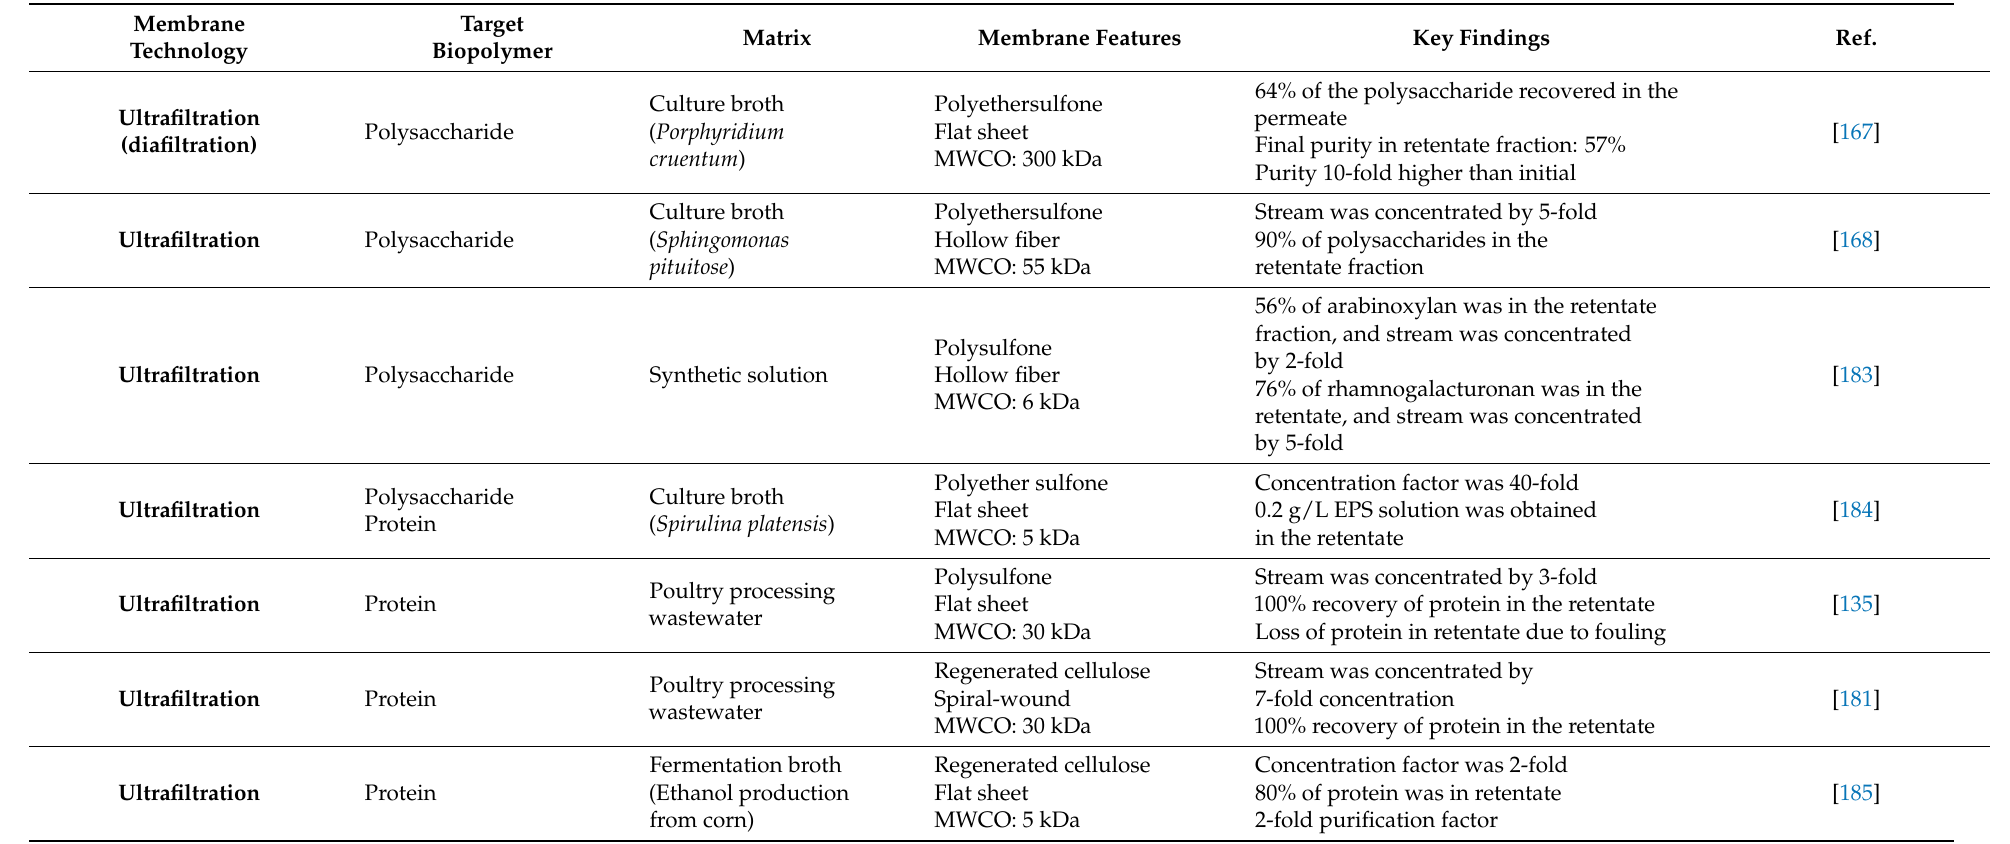
Table 5. Examples of membrane processes reported in the literature, used for the concentration of biopolymers from different